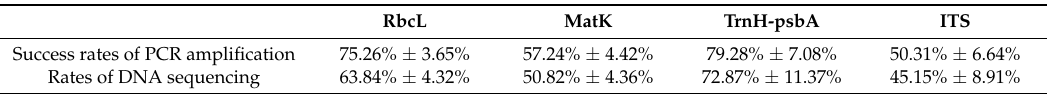
Table 1. Results of PCR amplification success rate and DNA sequencing rate for rbcL, matK, trnH-psbA, and internal transcribed spacer (ITS), respectively. RbcL